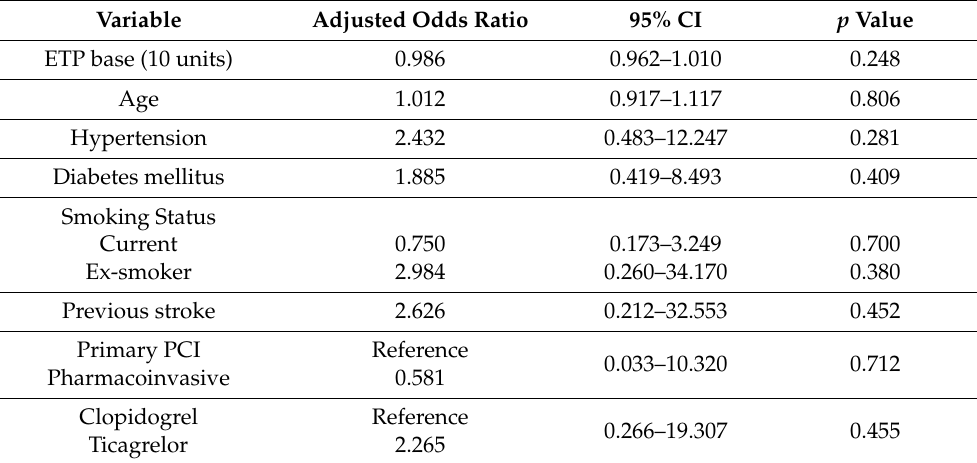
Table 5. Predictors of adverse ventricular remodeling ( ≥ 20% increase of left ventricular end-diastolic volume) outcome.